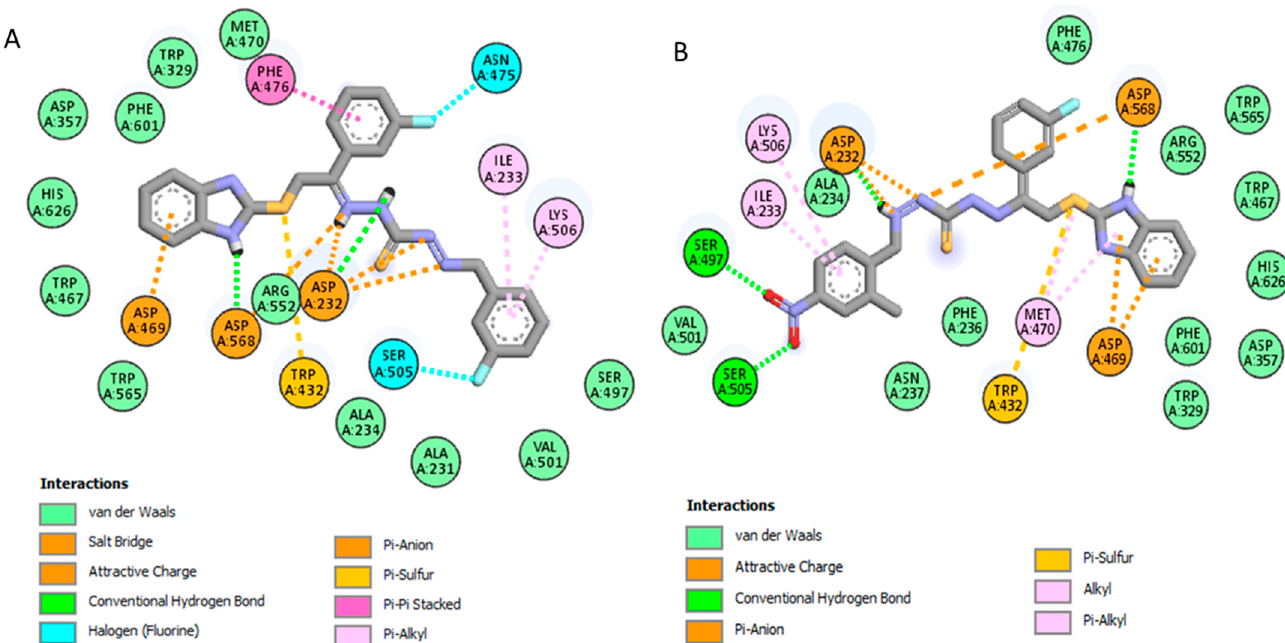
Figure 8. Profile for potent compounds against α -Glucosidase indicates the surface of the corresponding enzyme represent the PLI profile for compound ( A ) 19 and ( B ) 20.